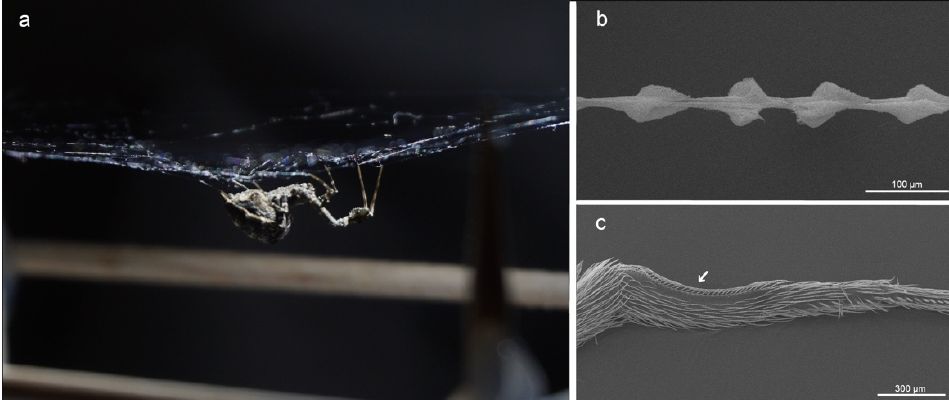
Figure 1. Cribellate spiders use combs on their hindlegs to brush nanofibers in puffy structures. ( a ) The feather-legged lace weaver, Uloborus plumipes . ( b ) SEM images of the spider’s capture thread employing a mesh of thousands of nanofibers forming puffy structures. ( c ) SEM images of the hind leg of U. plumipes . The arrow indicates the position of the calamistrum, the anti-adhesive comb on the metatarsus. Specimens were gold-sputtered before SEM examination.